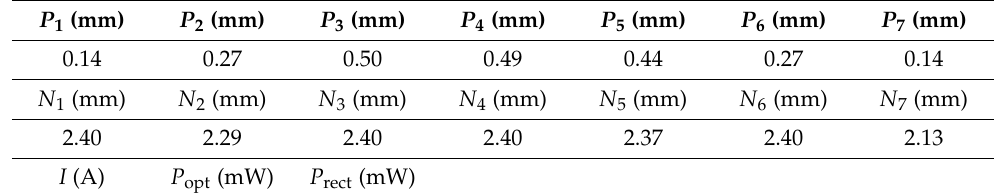
Table 4. The design parameters of the IVCS optimization.